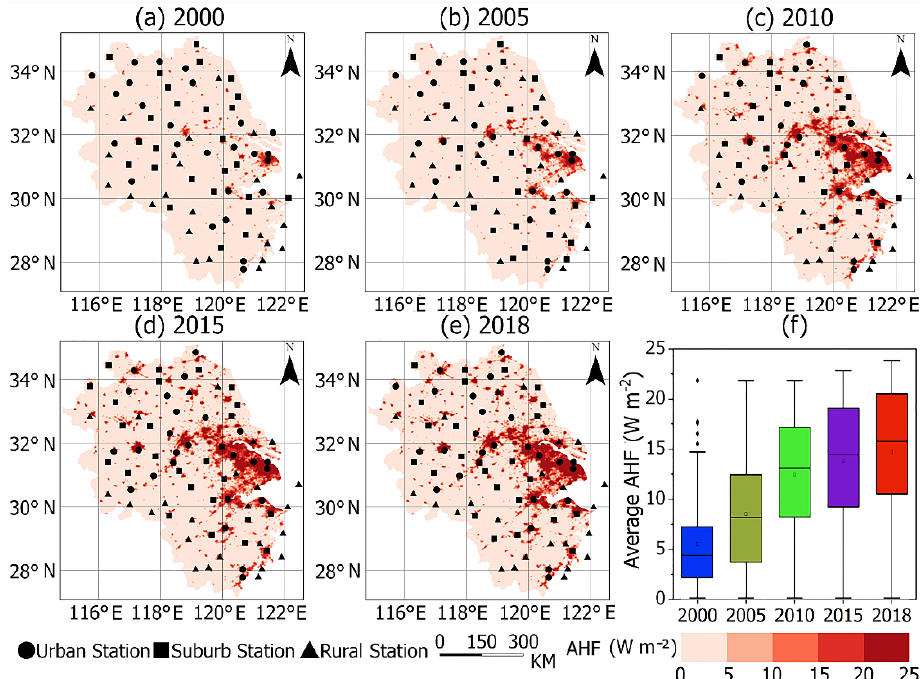
Figure 4. Maps of the AHF in the YRD from 2000 to 2018. ( a ) 2000, ( b ) 2005, ( c ) 2010, ( d ) 2015 and ( e ) 2018. ( f ) The average AHFs in a 5-km buffer zone around 76 stations in different years. Figure 5 shows the correlation between the AHF and the level of urbanization. As the AHF in the buffer zone around the station increased, the x value of the curve’s peak moved to the right. This indicates a positive correlation between the AHF and the built-up areas. The difference between the five curves weakened over time and this phenomenon was concentrated in the SL, M and SH levels. The three curves moved closer together, showing that the relationship between the distribution of different AHF levels and urbanization was decreasing. However, the curve of the levels of L and H were still quite different from the other curves, the peak height of the L level curve was getting lower and lower, while the H level was gradually increasing. Among the average of the 76 stations, the L level decreased from 52.28% (2000) to 11.39% (2018), whereas the H grade increased from 3.94% (2000) to 43.93% (2018) (Figure 5). This shows that urbanization has increased significantly in different regions, leading to an increase in the AHF in the buffer zone of different stations; most of the trends were similar. Only the AHF of the stations in large cities was significantly higher than the AHF at other stations.